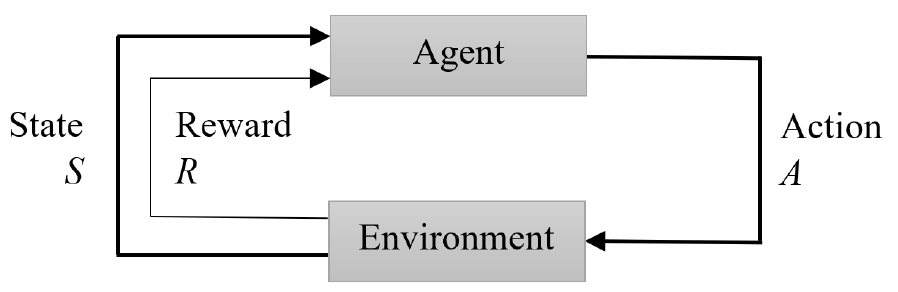
Figure 1. Reinforcement Learning principle: the agent interacts with the environment through an action A , changing its state S and receiving a reward R (adapted from